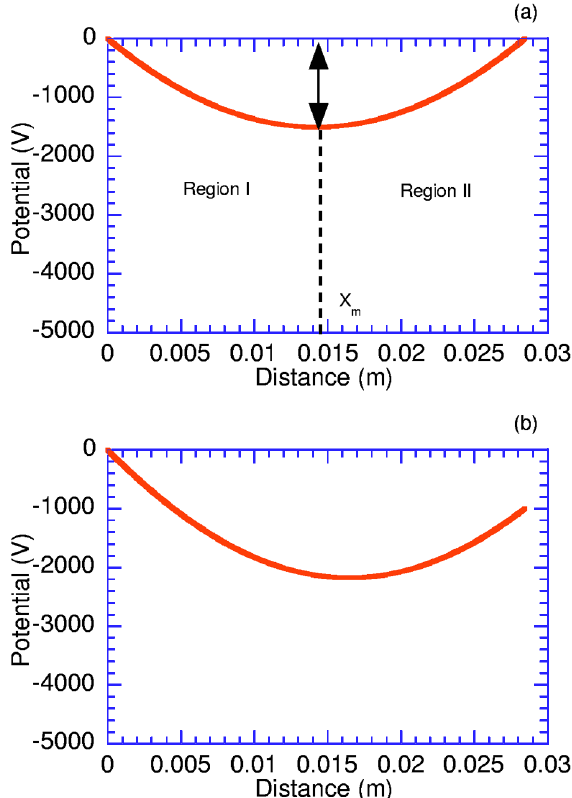
FIG. 4. (Color) Potential distribution with a potential mini- mum. Beam energy is 5500 eV. (a) Retarding voltage at 0 V. (b) Retarding voltage at (cid:7) 1000 V .